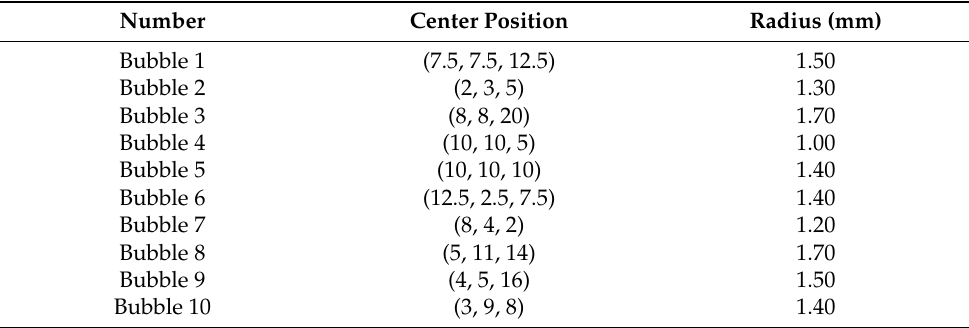
Table 6. The center position and radius of 10